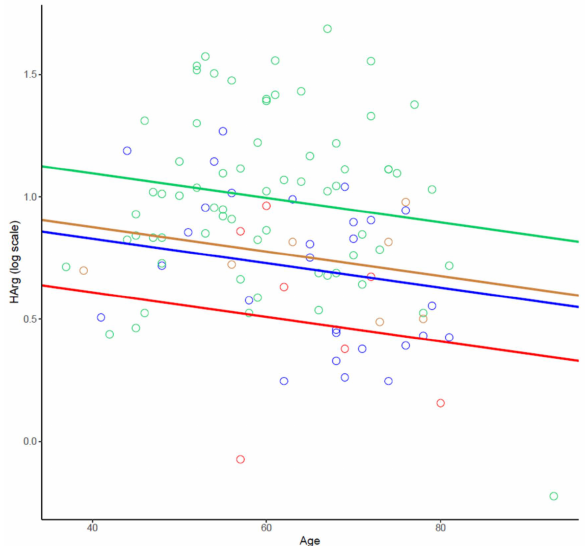
Figure 6. Covariance analysis of HArg in no-STEMI (no-CAD, nonob-CAD, and ob-CAD) and STEMI cohort, based on sex. Female no-STEMI as blue circles, female STEMI as red circles, male no-STEMI as green circles, and male STEMI as brown circles. Data are represented as individual